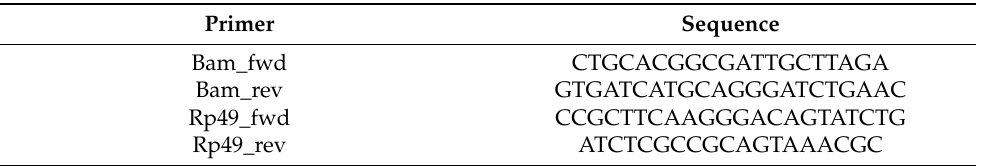
Table 2. List of primers used for